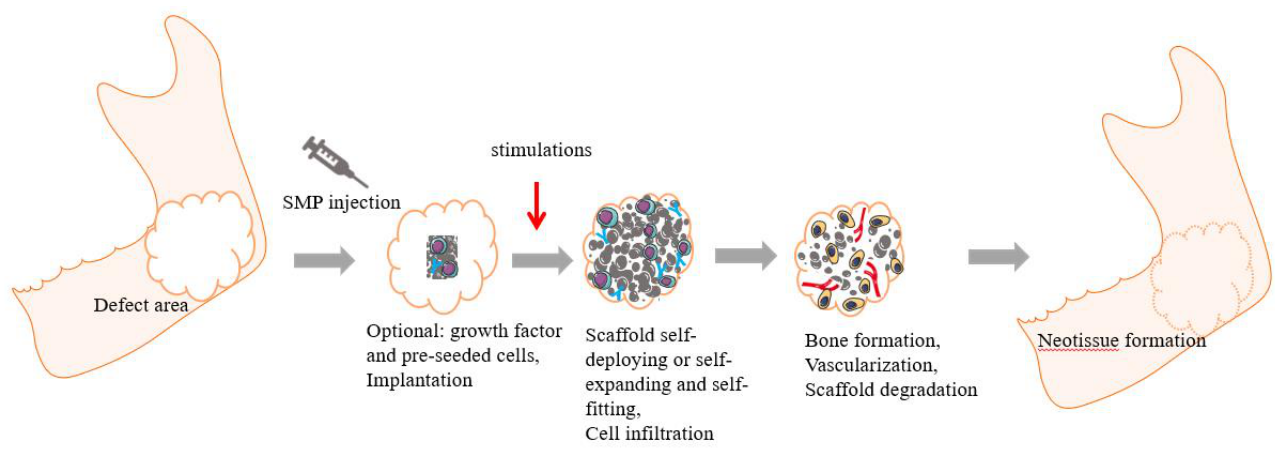
Figure 2. General schematic diagram of SMP loaded growth factors applied in bone tissue engineering. Based on simulations, a highly porous scaffold carrying optionally loaded growth factors and cells is implanted in the bone defect area to trigger its shape memory property and fill in the defect area. Subsequently, the cells and growth factors affect the scaffold to promote bone formation and angiogenesis. Eventually, the scaffold is degraded and replaced with neotissue [13].